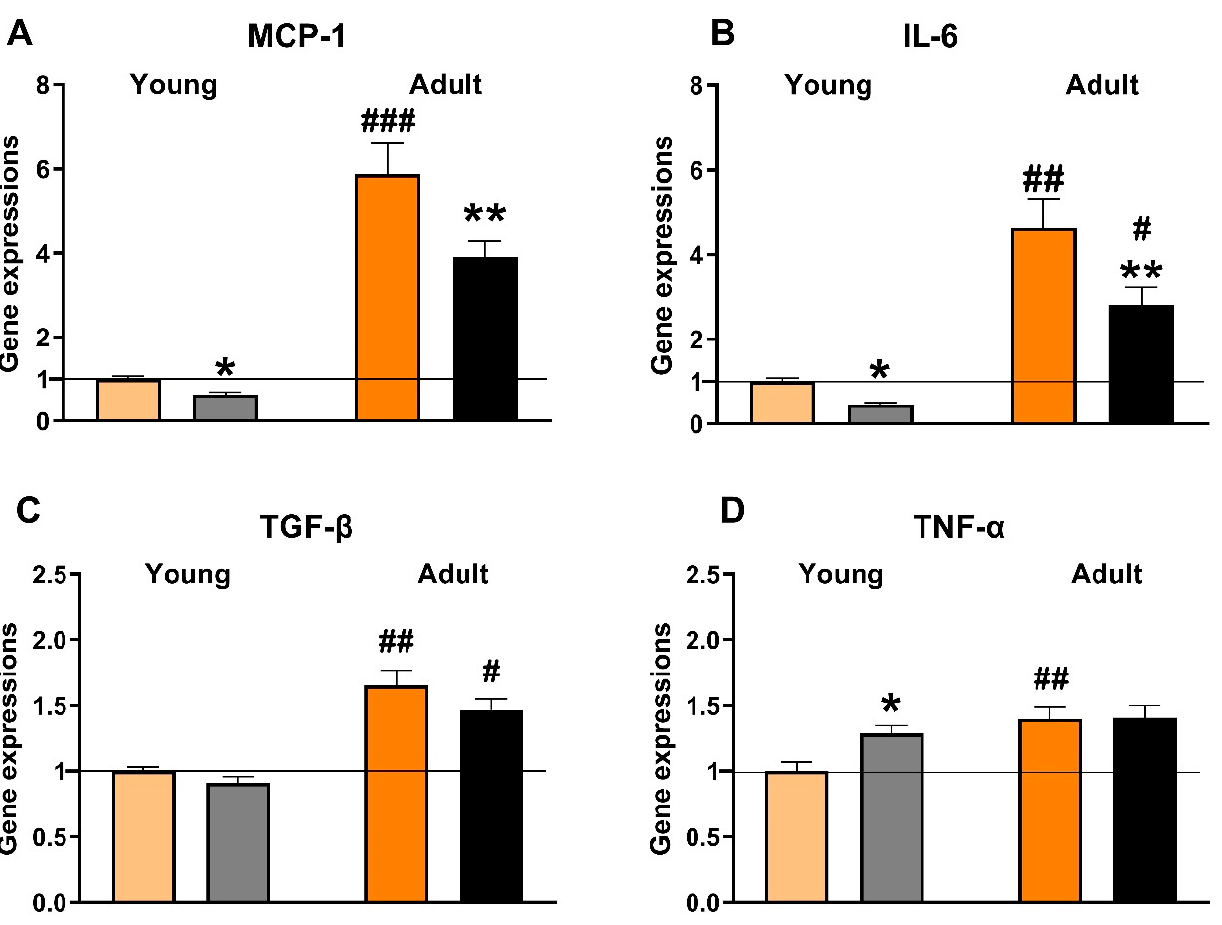
Figure 3. Relative mRNA expression of selected pro-inflammatory genes in the kidneys—monocyte chemoattractant protein-1 (MCP-1; ( A )), Interleukin-6 (IL-6; ( B )), Transforming growth factor- β (TGF- β ; ( C )), and Tumor necrosis factor- α (TNF- α ; ( D )). # p < 0.05 vs. respective young group. * denotes p < 0.05; ** denotes p < 0.01; ## denotes p < 0.01; ### denotes p < 0.001. Data are means ± SEM; n = 7–8 for each group.